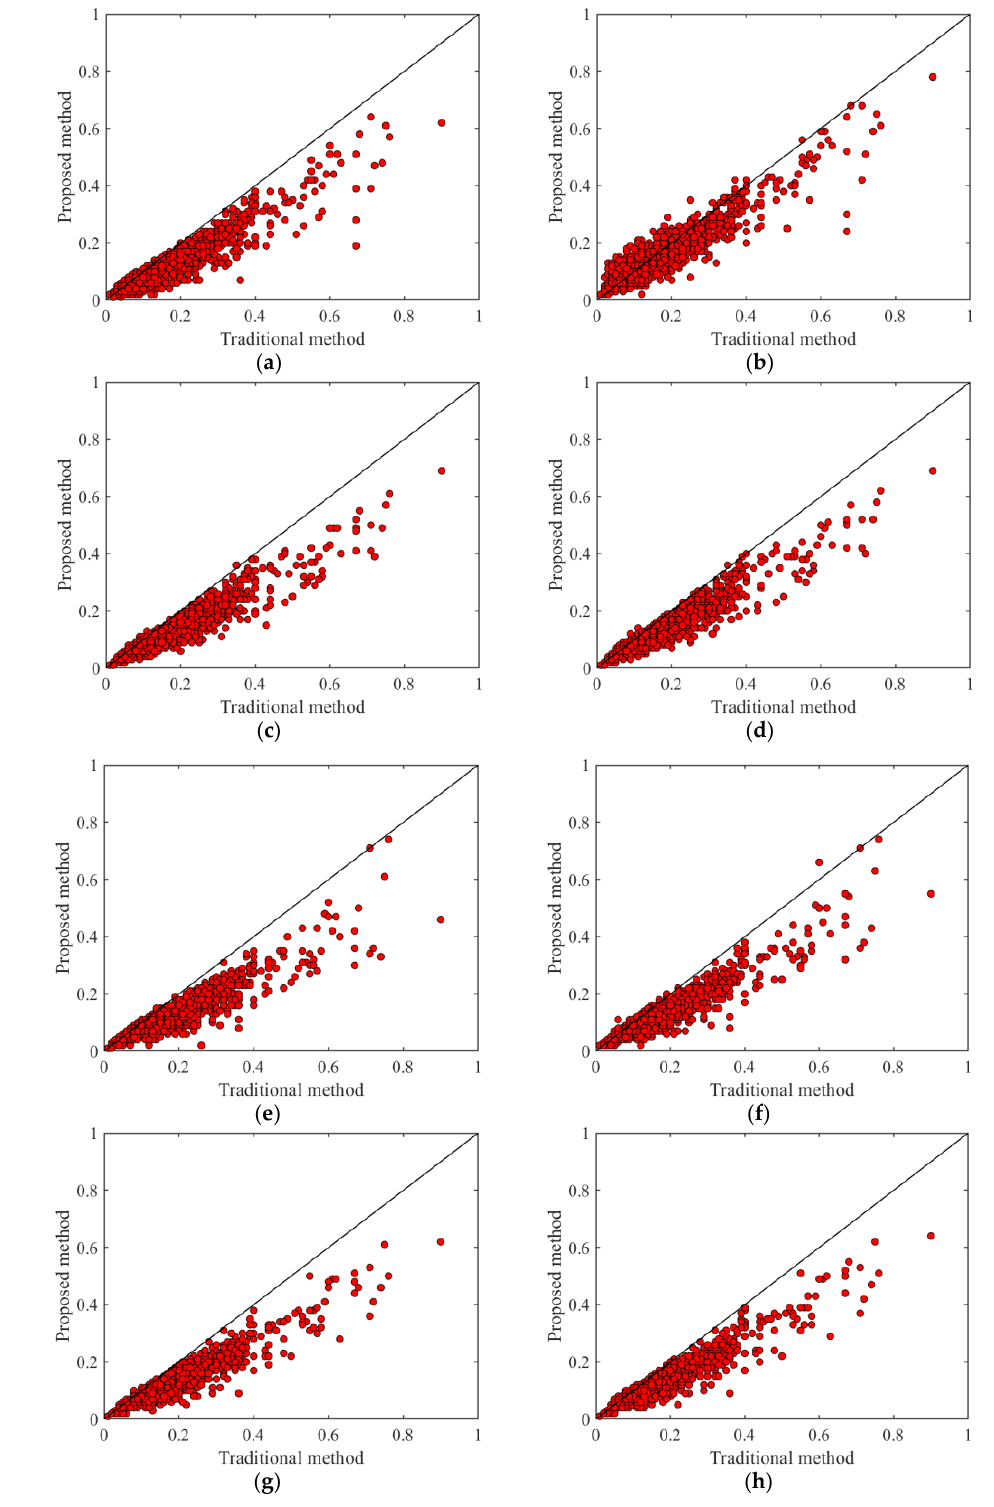
Figure 8. The high-pass cut-off frequency was obtained using a model that only trains the fully connected layer (unit: Hz). ( a ) The VGG19 when not considering probability; ( b ) the VGG19 when considering probability.